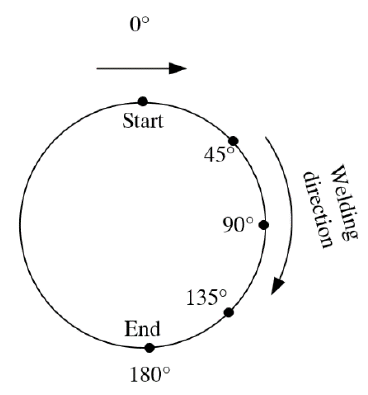
Figure 4. Schematic diagram of welding position.